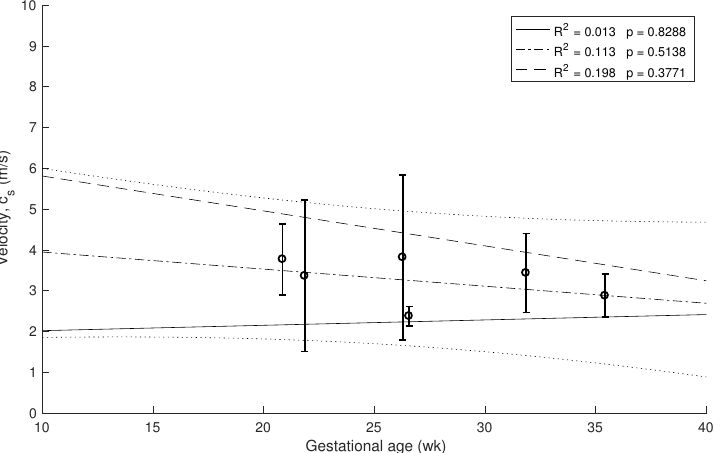
Figure 7. Relationship between cervical stiffness assessed by shear wave speed using 0.5 kHz waves and gestational age at time of